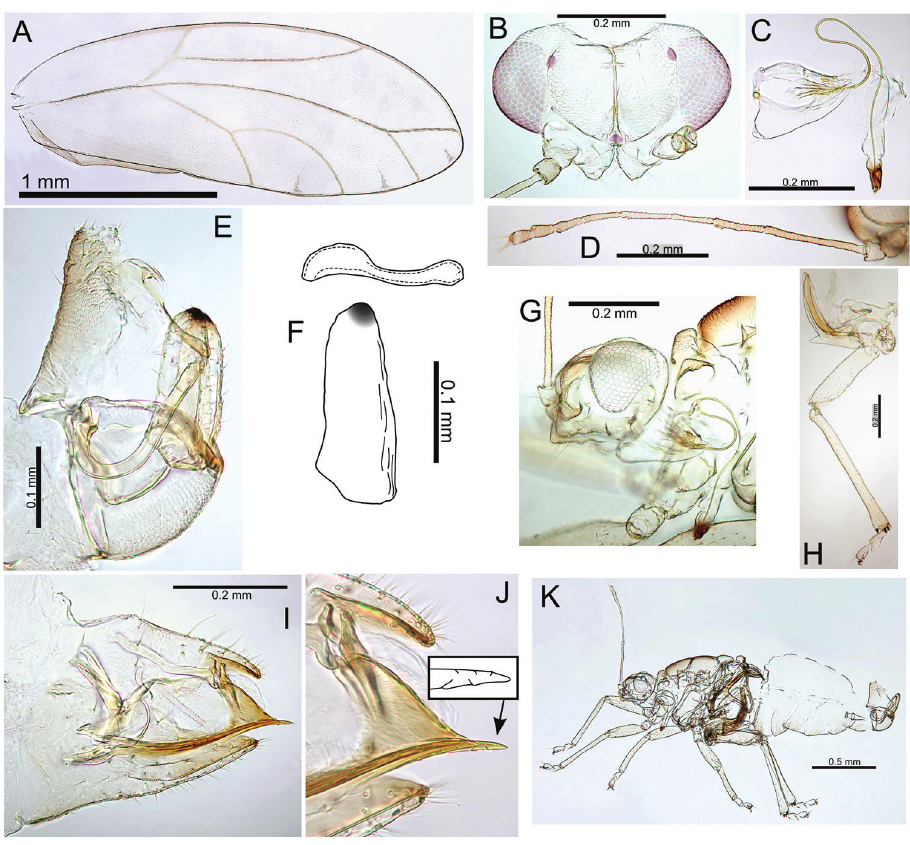
Figure 18. Pariaconus namaka sp. n. A fore wing B head C proboscis D antenna E male terminalia F aedeagus and paramere G head H hind leg I female terminalia J ovipositor (serrations indicated) K male. VL:GP av. 2.35); short to minute setae on vertex and thorax; distal proboscis segment short (av. length 0.07); hind tibia long and slender, longer than head width (ratio HW:HT av. 0.78) (Fig. 18B–D, G–H, K). Male terminalia (Fig. 18E–F): paramere shorter that proctiger (ratio MP:PL 1.13), more or less parallel sided before tapering below a rounded apex with interiorly directed hook; distal aedeagus segment shorter than paramere (ratio PL:AEL av. 1.17) with base rounded and slightly inflated, and a rounded, shallow hooked apex (ratio AEL:AELH av. 2.41). Female terminalia (Fig. 18I–J): proctiger moderately short, dorsal surface more or less straight, apex acute, anal ring long (ratio FP:RL 3.06); subgenital plate long (ratio FP:FSP av. 0.89), without or with very slight medial bulge ventrally, apex acute; ovipositor apex with reduced serra- tions (2 above, 0-2 below), valvulae dorsalis not strongly convex dorsally. Egg. Unknown. Immature. Colour and structure: Pale cream to orange-yellow. 5 th instar: Ovoid and ventro-dorsally flattened wing buds only slightly protruding and distinct